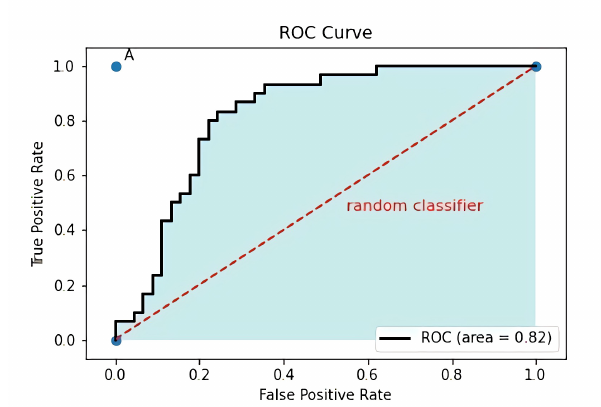
Figure 6. An example of ROC Curve